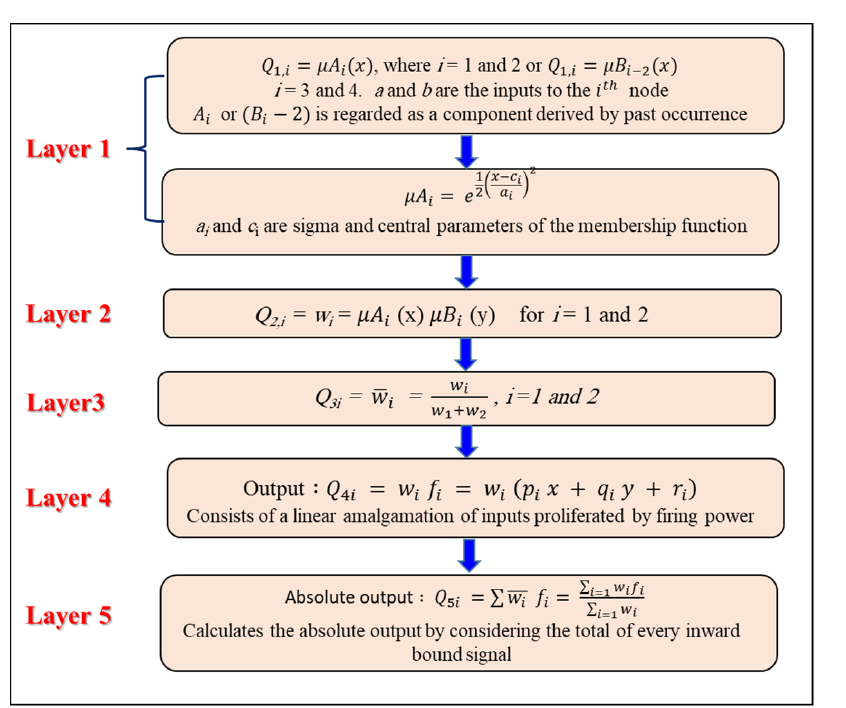
Figure 5. An ANFIS architecture for IWQ prediction.